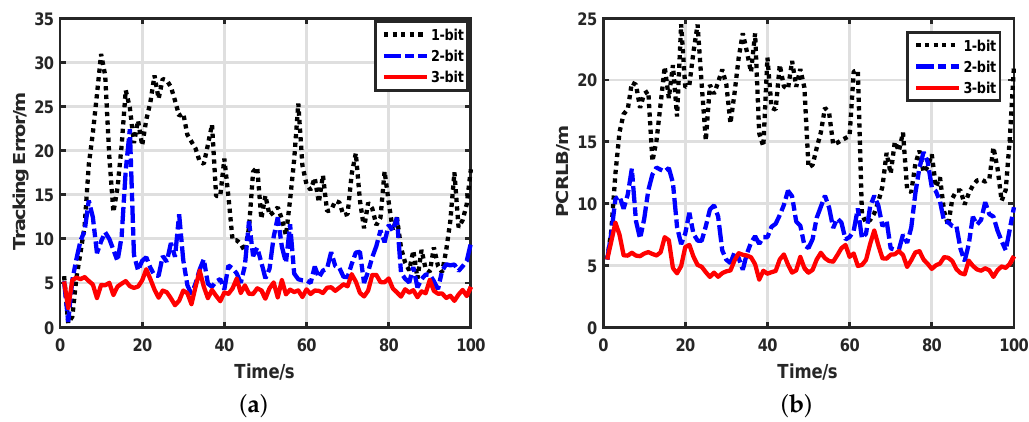
Figure 5. Target tracking performance of uniform quantization-based tracking scheme with different data lengths. ( a ) Target tracking error of uniform quantization-based tracking scheme; ( b ) posterior Cramer–Rao lower bound (PCRLB) of uniform quantization-based tracking scheme.